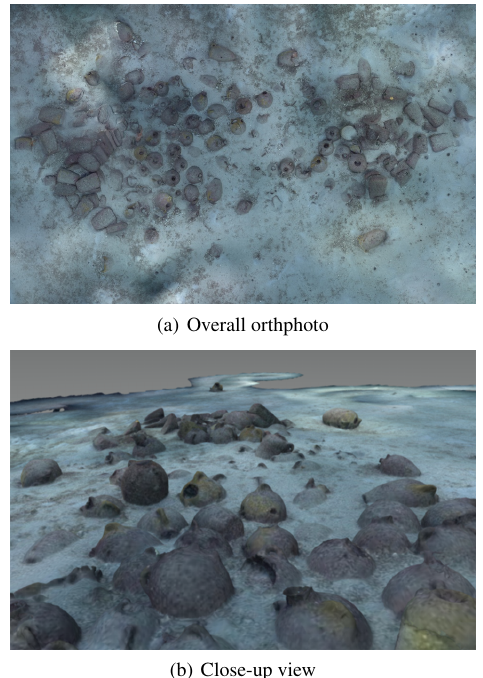
Figure 1. Example of a 3D model of an underwater site that is a Phoenician shipwreck recently discovered located near